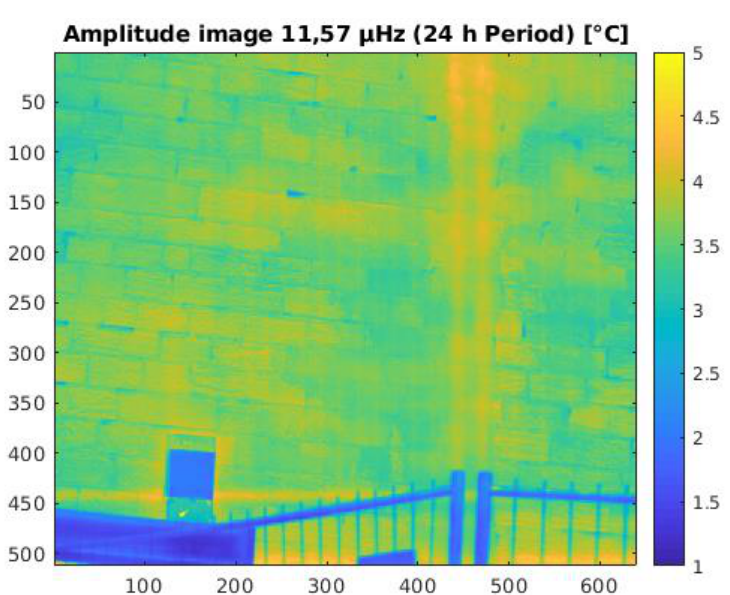
Figure 9. Amplitude image of the fundamental 24 h period. This image depicts the 24 h temperature amplitude average in every pixel over the 96 h measurement period |𝑆 𝑥𝑦 | .